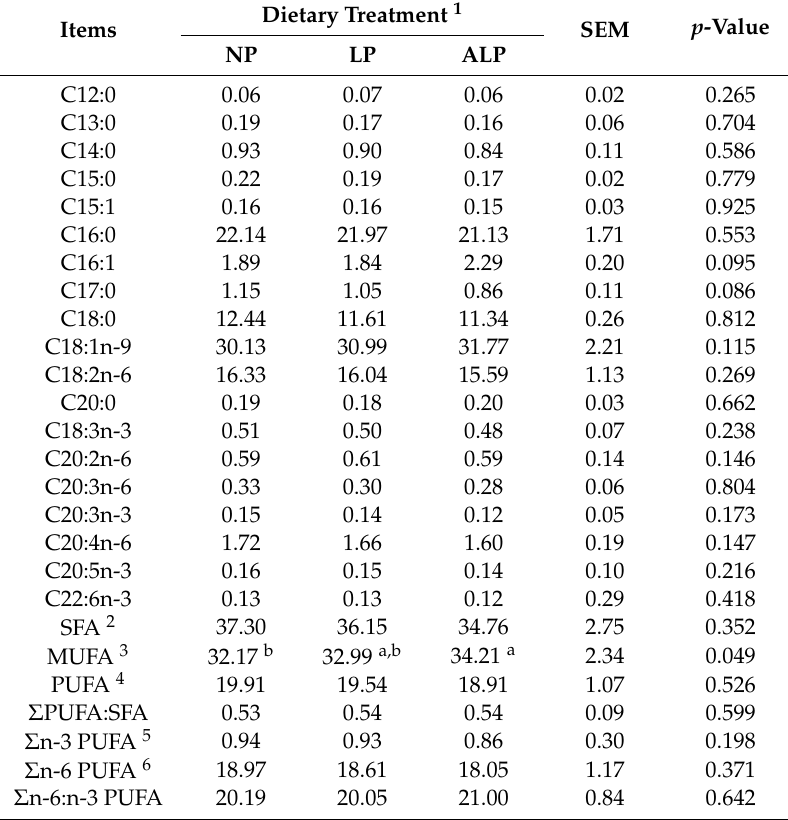
Table 4. Fatty acid composition (% of total fatty acids) of longsissimus dorsi muscle from growing pigs fed normal protein or low-protein diets without or supplemented with AKG.